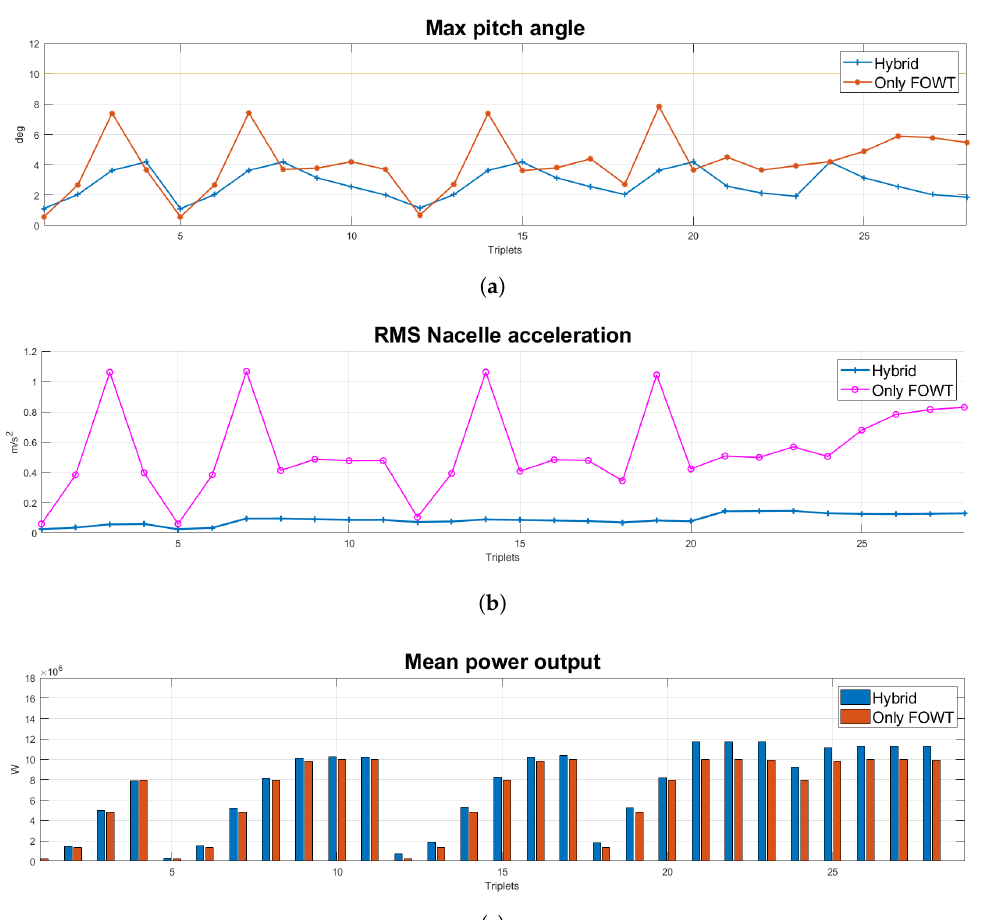
Figure 20. Max pitch angle ( a ), RMS nacelle‘s acceleration ( b ) and Mean power output ( c ) for each sea-state triplet between two